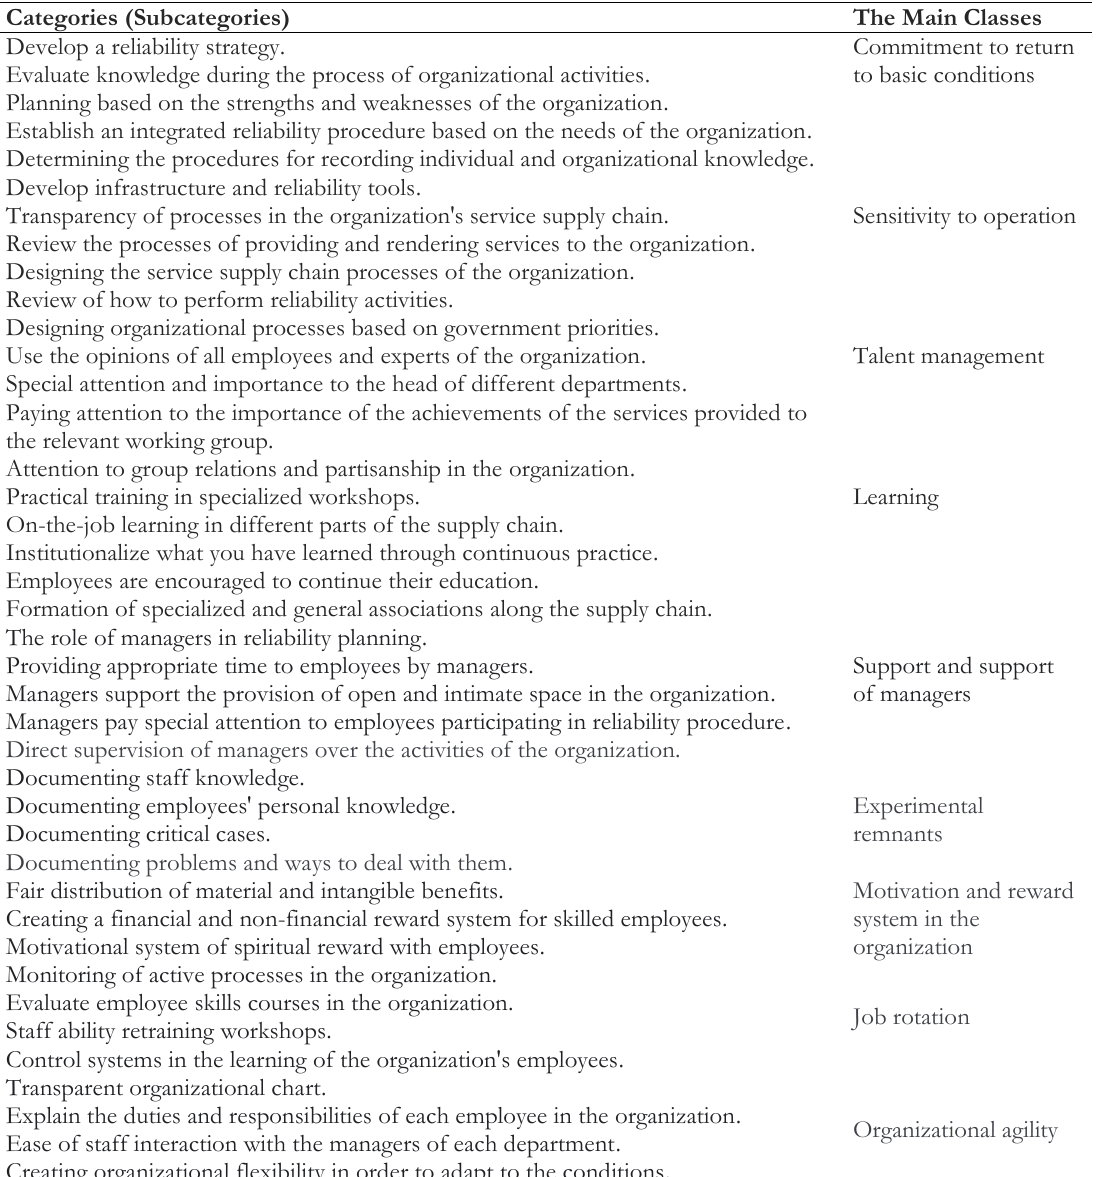
Table 2. Forming general classes of